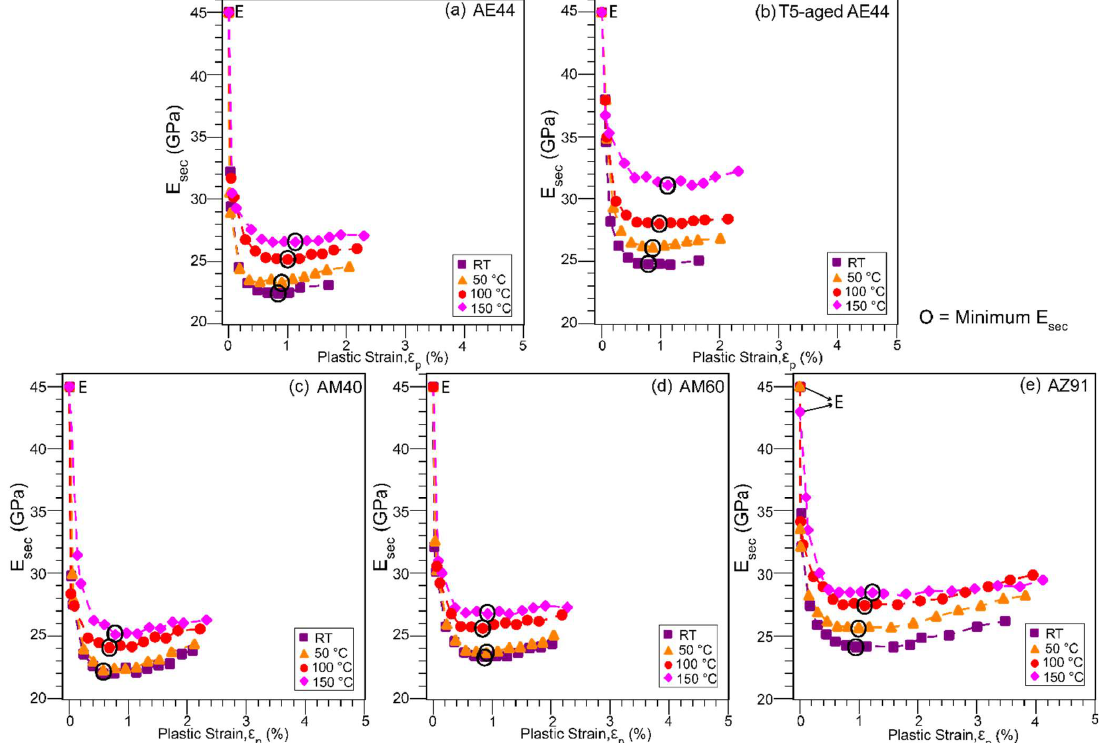
Figure 5. The secant elastic modulus, E sec , as a function of the applied plastic strain, ε p , for the alloys and temperatures of Figure 4. E is the elastic modulus at zero plastic strain, estimated from a low stress region of 30 MPa. The symbol ‘O’ denotes the minimum E sec .